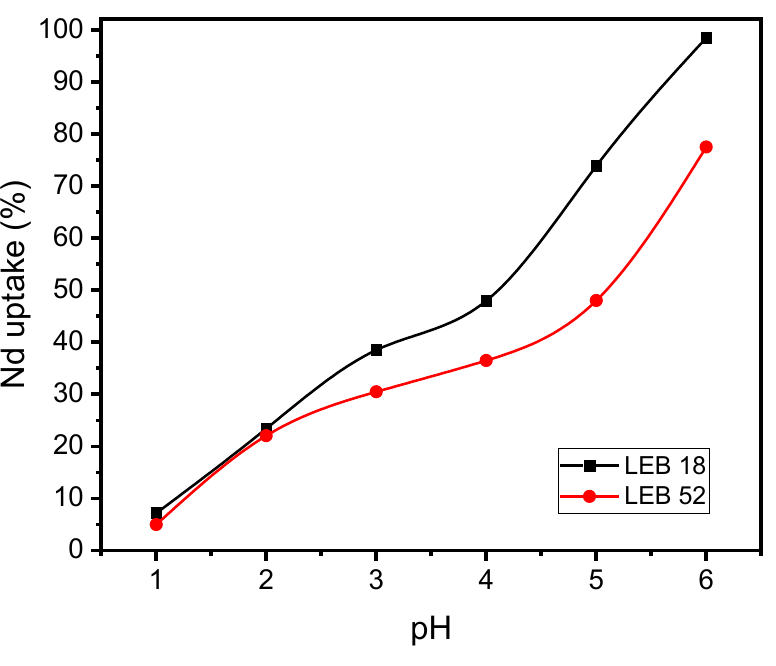
Figure 3. pH effect on the Nd biosorption by LEB-18 and LEB-52 S. platensis . Initial concentration 20.0 mg L −1 , temperature 25 °C, adsorbent dosage 2.0 g L −1 .